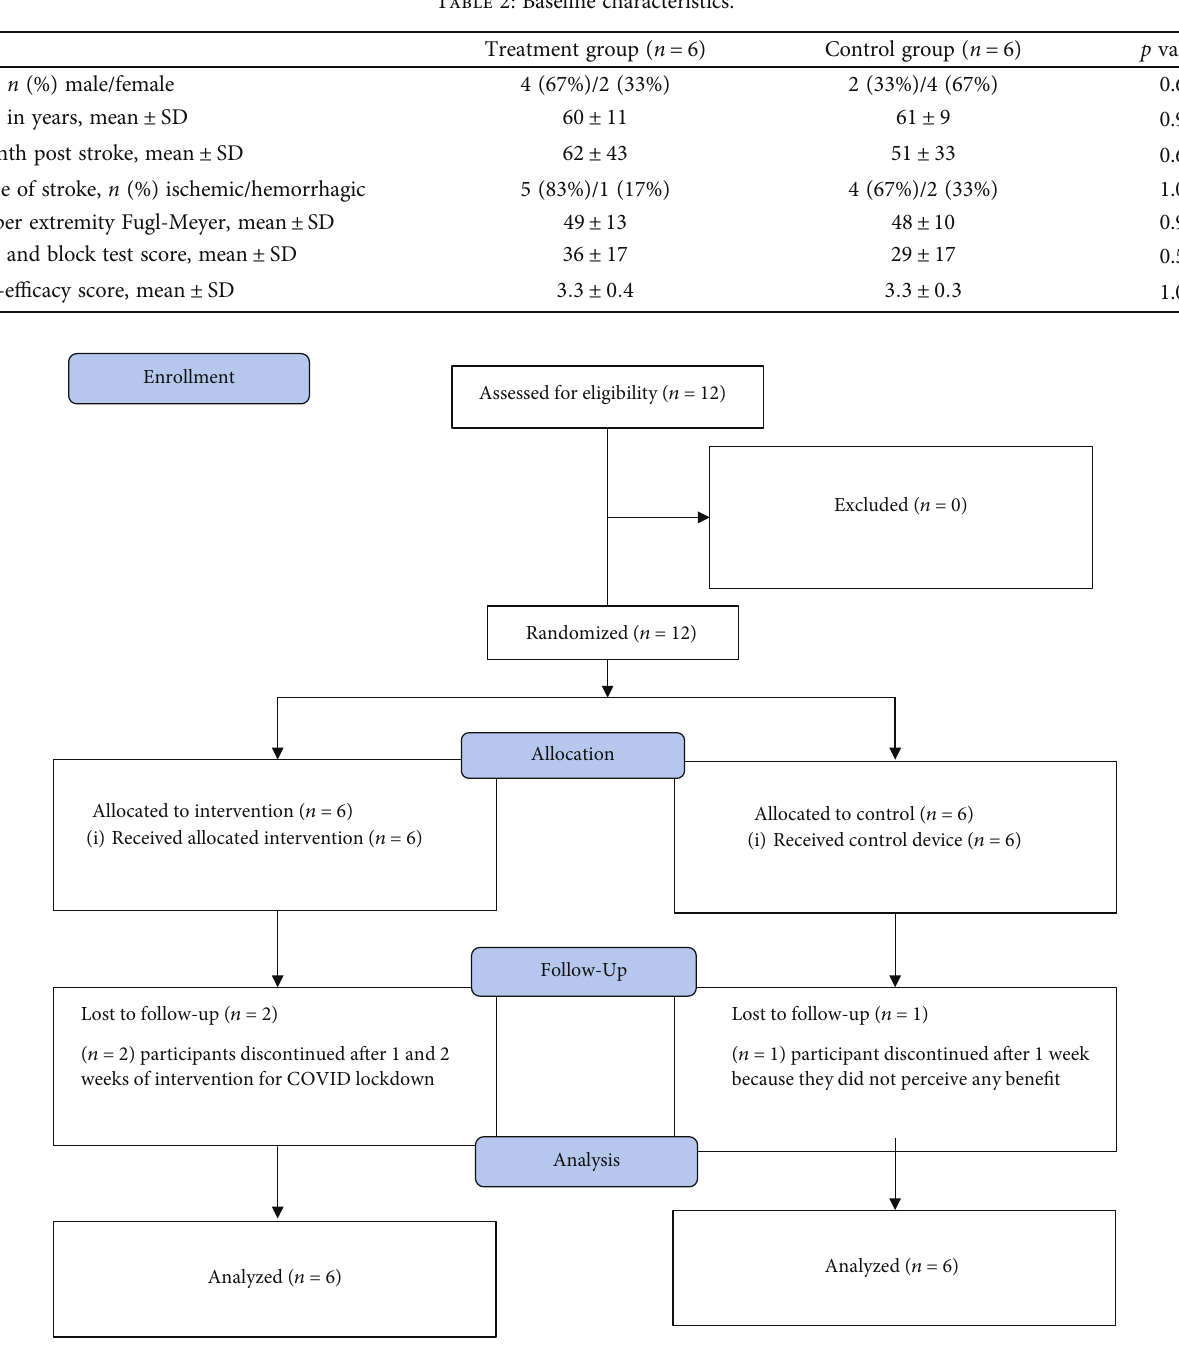
Figure 2: Consort fl ow